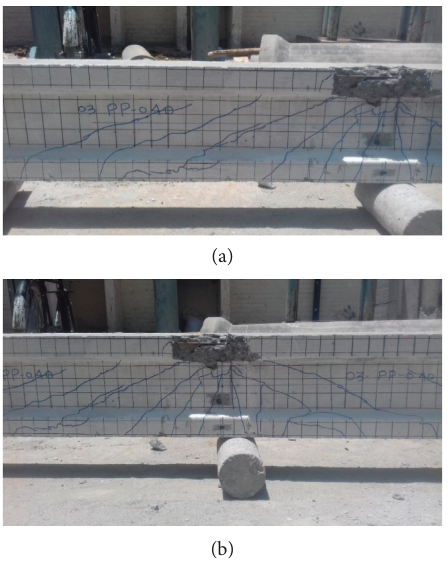
Figure 17: Crack patterns of B3-PPFRC-1.